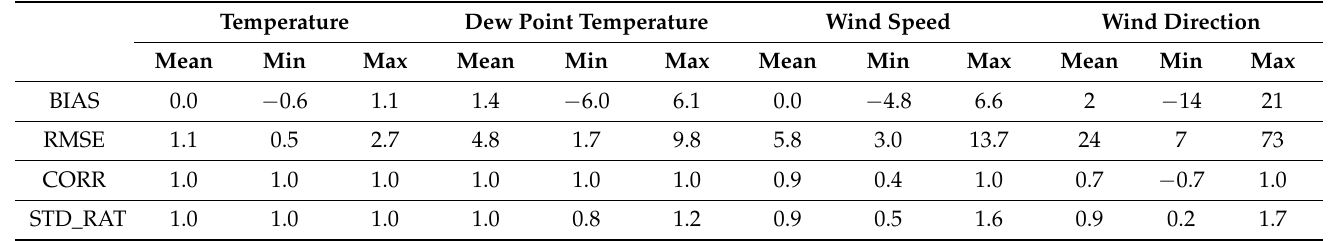
Table 5. Values of BIAS and RMSE for temperature ( ◦ C), dew point ( ◦ C), wind speed (m/s) and direction (degrees). Values of CORR and STD_RATIO for temperature, dew point, wind speed and direction (non-dimensional). Temperature Dew Point Temperature